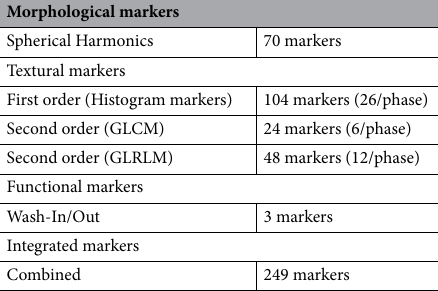
Table 3. Illustration of different categories and their associated number of extracted markers for each